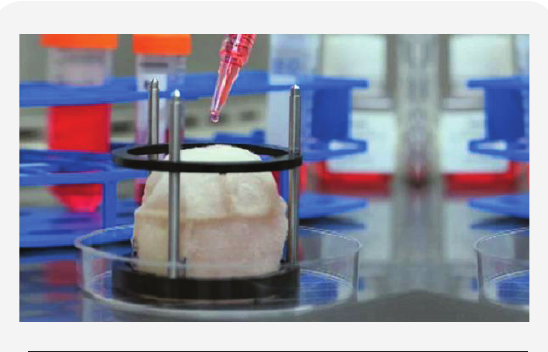
Figure 6. A form shapes regenerating a human bladder. Source: Wake Forest Institute for Regenerative